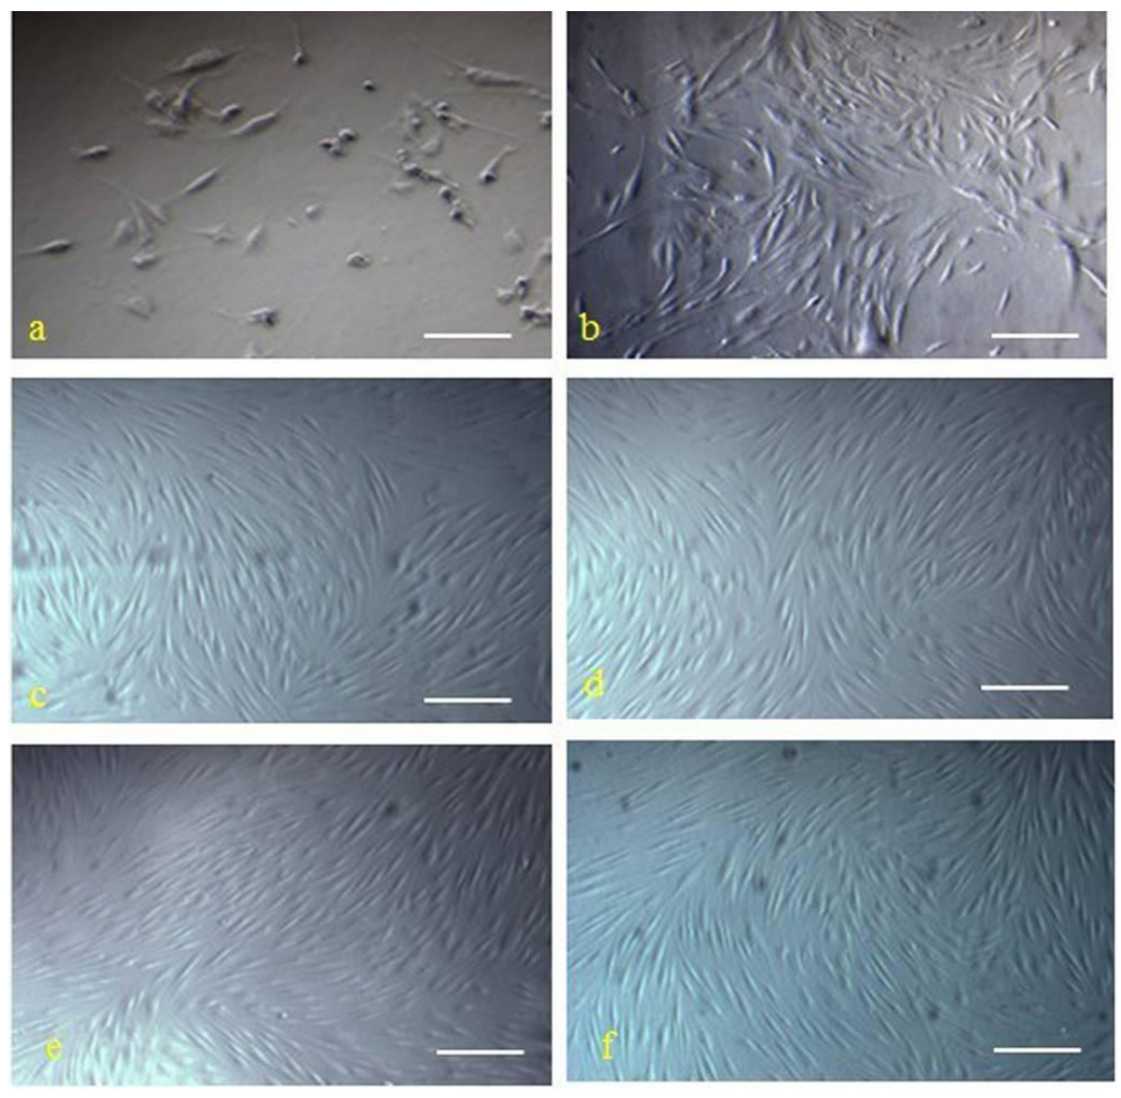
Figure 1. The morphology of isolated cells from bone marrow presented features of hMSCs. Cells isolated from bone marrow at 48 h after seeding ( a , scale bar: 100 μm) and cells from individual clones grew into shoal or whirlpool shapes ( b ,scale bar: 100 μm), passage 3 ( c ), passage 6 ( d ), passage 9 ( e ), and passage 12 ( f ), respectively, were photographed under a microscope (magnification, 200×; Scale bar, 200